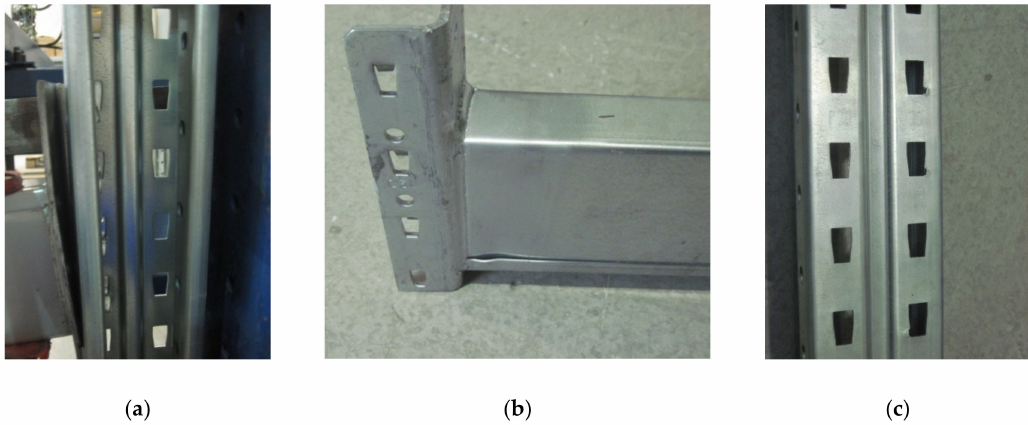
Figure 18. Failure modes in case of the assembly with an upright region having a thickness equal to 2.00 mm and a connector with four tabs: ( a ) failure mode of the connector, ( b ) failure mode of the beam, and ( c ) failure mode of the upright